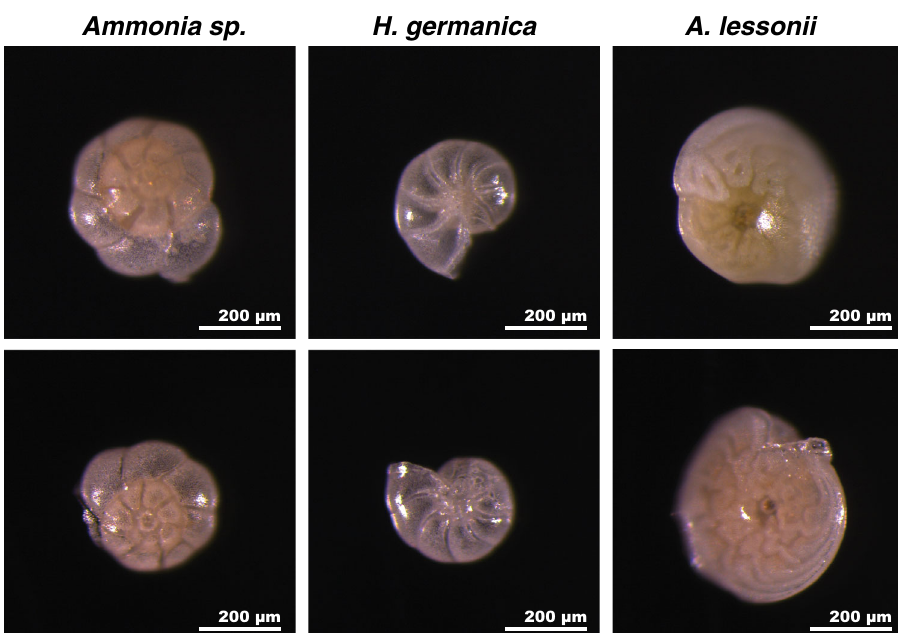
Fig. 1 Appearance of tests before and after incubation. Stereo microscopy images of Ammonia sp., H. germanica , and A. lessonii tests before (top row) and after (bottom row) incubation for 6 days at 90 °C in arti fi cial seawater (ASW) with a 18 O/ 16 O ratio of 0.30. All images were taken at the same scale, under identical illumination conditions, and using the same microscope and